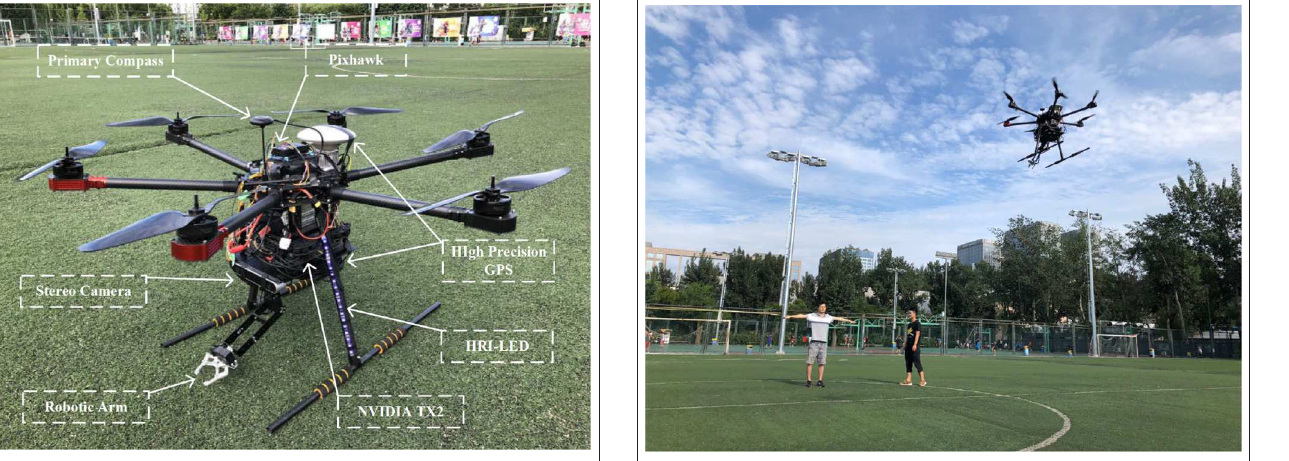
diag (10, 10, 4) and M 2 diag (0.2, 0.2, 0.28) = = 1.2, ξ 2, i 0.3. The results = =